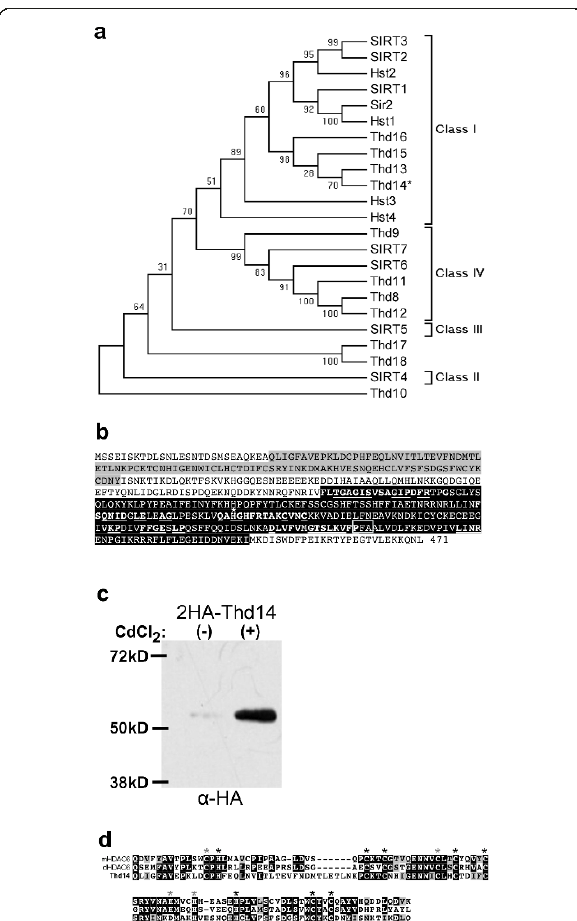
Figure 4 Thd14 resembles a class 1b sirtuin . a Phylogenetic tree comparing the primary structure of the T. thermophila sirtuins including Thd14 (asterisk) with that of the yeast sirtuins (Sir2 and Hst1-4) and the seven human sirtuins (SIRT1-7) (unweighted-pair group methods using average linkages). The scale (x-axis) represents evolutionary distance as calculated using the Poisson correction method, with the units of number of amino acid substitutions per site. b Amino acid sequence of Thd14 translated from the gene sequence. The predicted zinc finger domain is highlighted in grey and the sirtuin domain is highlighted in black. The motifs of conserved amino acids present within the sirtuin core domain are in boldface type. Underlined letters indicate intraclass-conserved residues, used for sirtuin identification. The asterisk denotes the critical catalytic histidine residue in the ‘ HG ’ motif that is strictly conserved in all known sirtuins. Boxed is a sub-motif specific to class 1b sirtuins. c Cells expressing HA-Thd14 were grown in the absence “ (-)"or presence “ (+) ” of 1 μ g/mL CdCl 2 for 2 hrs to induce expression from the MTT1 promoter. Total cellular proteins were resolved by SDS-PAGE, transferred to nitrocellulose membrane, and subjected to immunoblot analysis using a -HA antiserum. d Amino acid alignment of the UBP-type zinc-finger domain from Thd14 with similar domains from murine and Drosophila HDAC6 (mHDAC6 and dHDAC, respectively). Asterisks mark conserved Cys and His residues; black asterisks denote those in HDAC6 that are essential for ubiquitin binding [24]. Conserved residues are shaded in black (for identical residues) and grey (for chemically similar